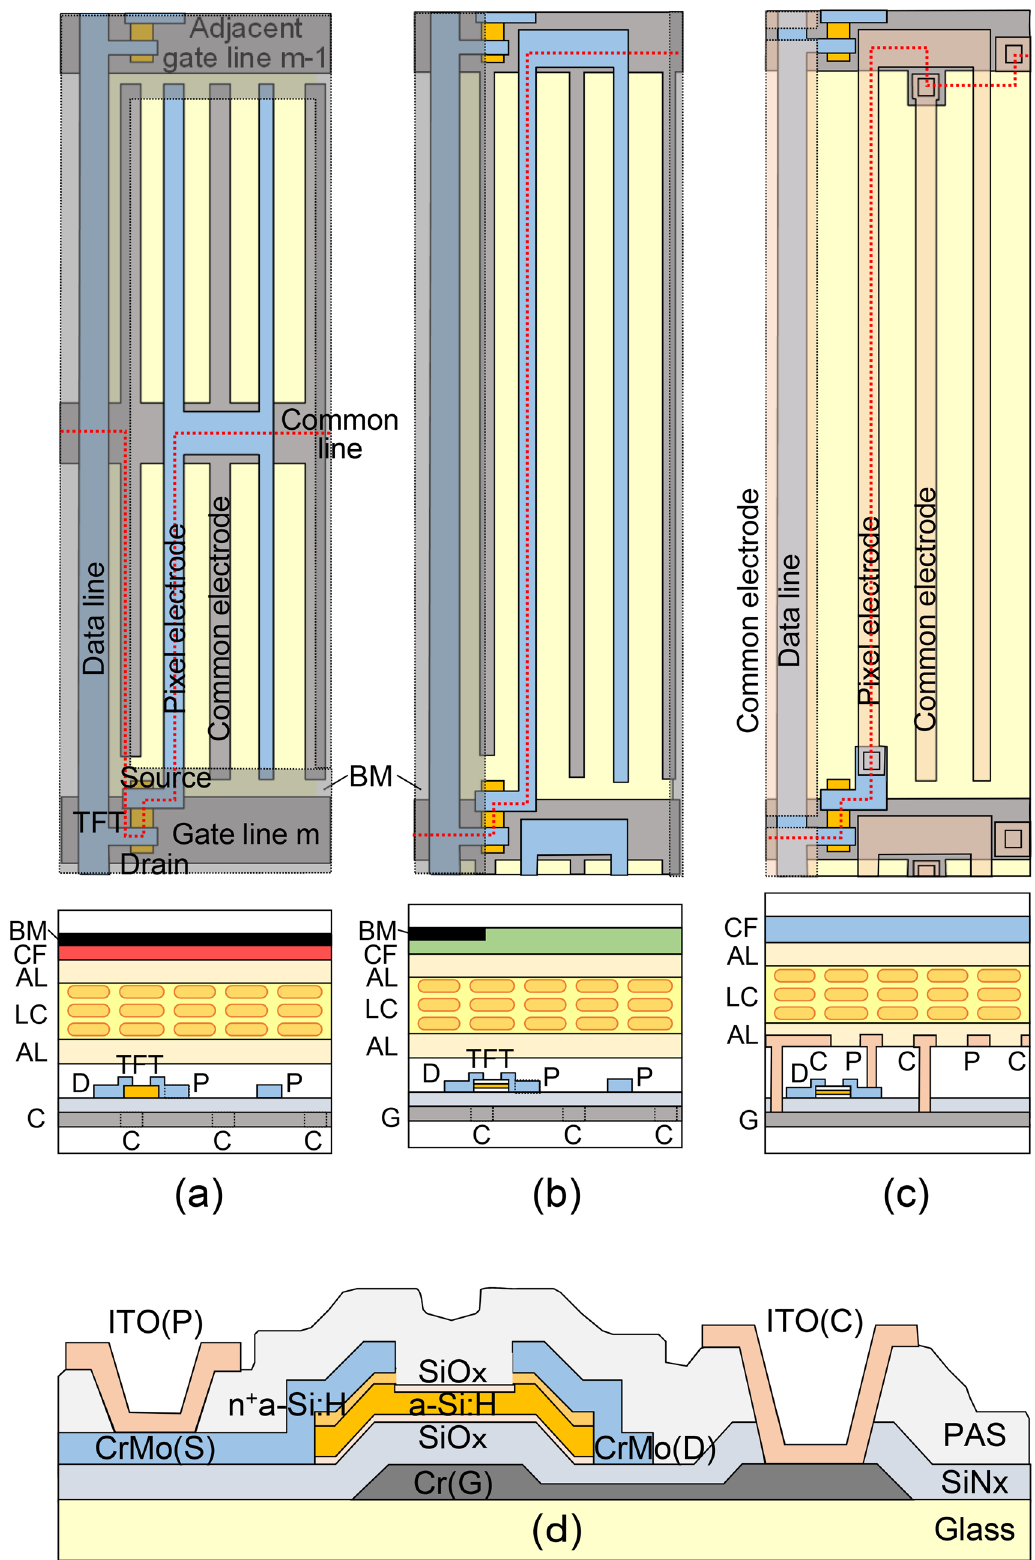
Figure 1. Pixel plane (top) and sectional views (bottom) of ( a ) the conventional structure, ( b ) the proposed CL structure without common line, ( c ) the proposed CLSE structure without common line and black matrix, with pixel and common electrodes made on the top of TFT substrate (G: gate, C: common, D: drain, P: pixel, AL: alignment layer, LC: liquid crystal, BM: black matrix, CF: color filter). Common electrodes are connected to the common line in the conventional structure, while they are connected to the adjacent gate line in the proposed structures. The red dotted line in each plane view indicates the cutting route for the corresponding sectional structure. ( d ) Detailed sectional structure of the CLSE